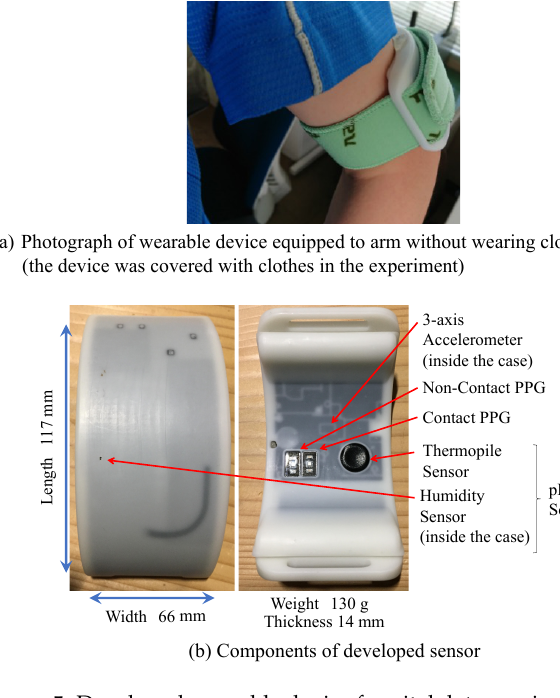
Figure 5. Developed wearable device for vital data sensing.